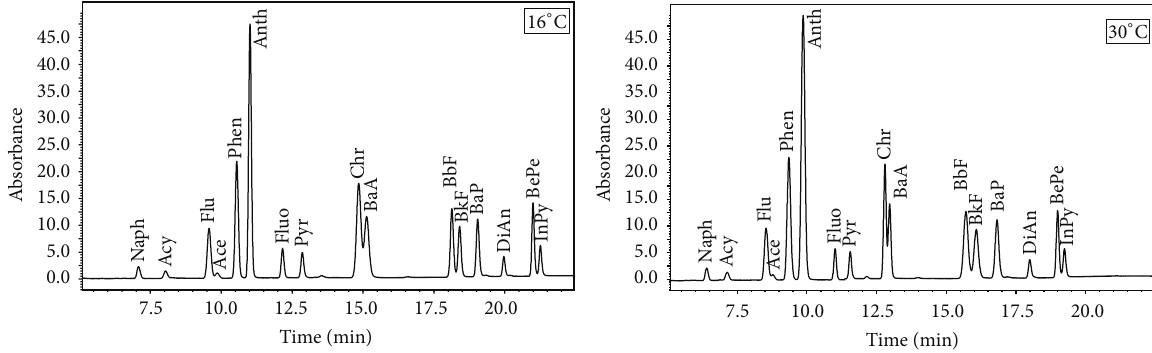
Figure8:Chromatogramsof16PAHsat500 𝜇 gL −1 obtainedwithKinetexat254